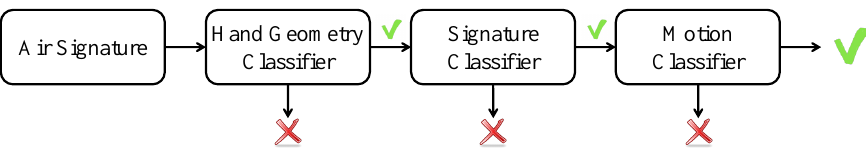
Figure 12. Flow chart of the decision